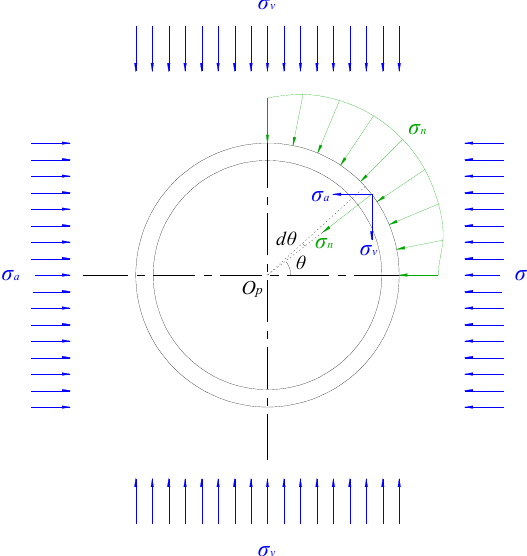
Figure 4. The earth pressure and the normal stress acting on the pipe.